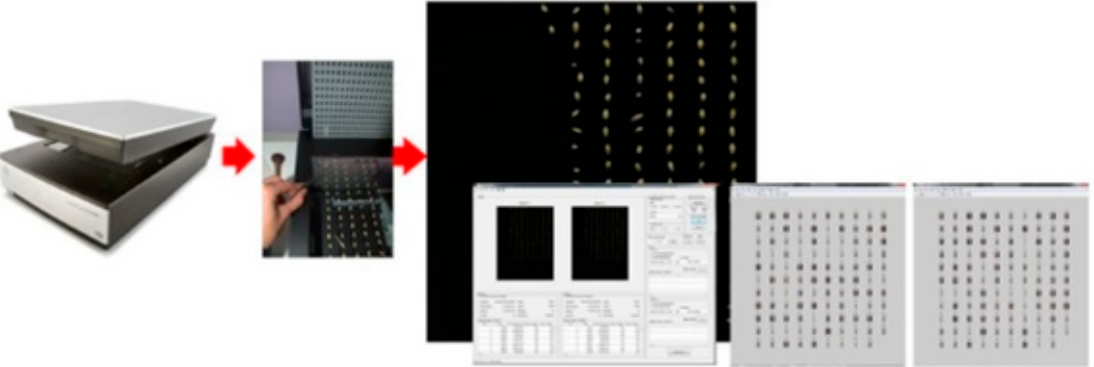
Figure 3. Acquisition and image processing of damaged malting barley grains using the original Hordeum v. 3.2 computer system created by B. Raba within MATLAB 2014b environment (Math- Works, Natick, MA, USA) using Image Processing Toolbox library.